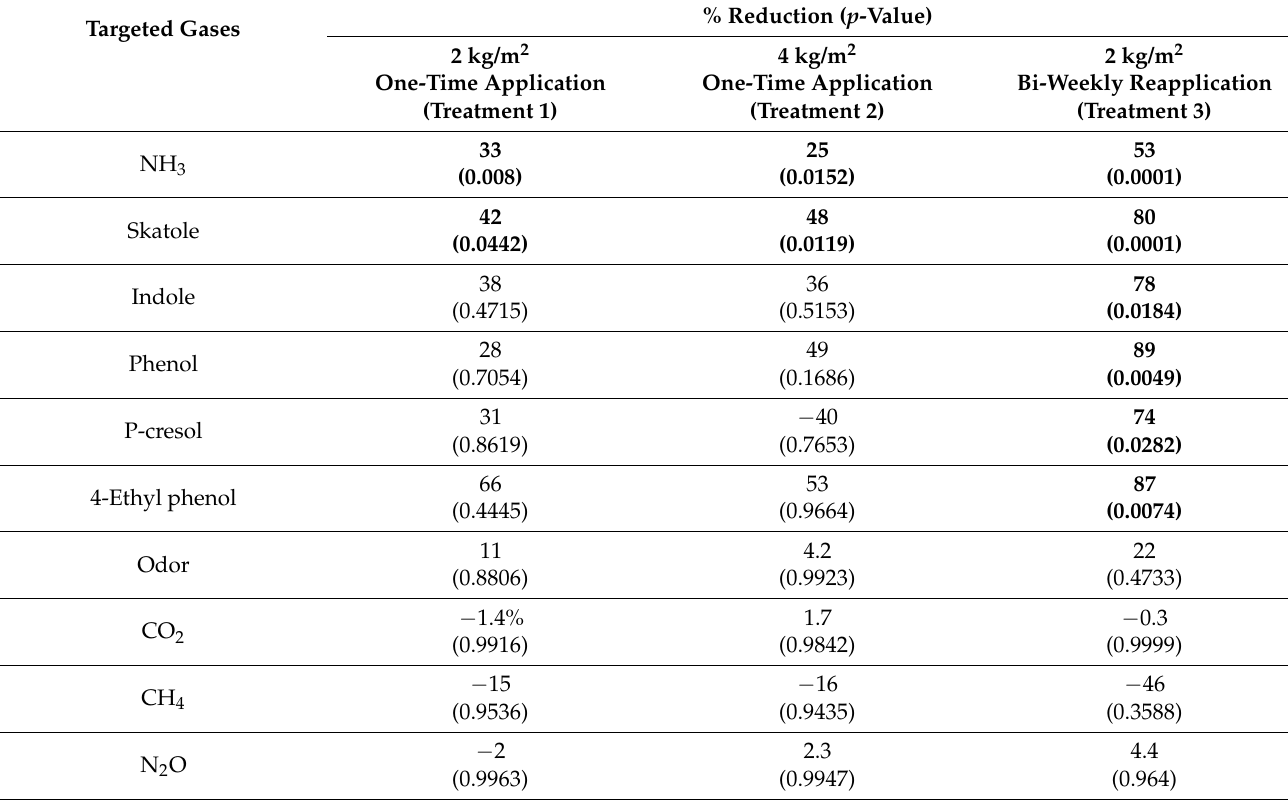
Table 1. Mitigation of gaseous emissions with highly alkaline and porous (HAP) biochar treatments. Effects of the dose (biochar mass/manure surface area) and bi-weekly reapplication. Statistically significant percentage reduction (Control vs. Treatment) of emissions are in bold. Negative percentage reduction signifies gas